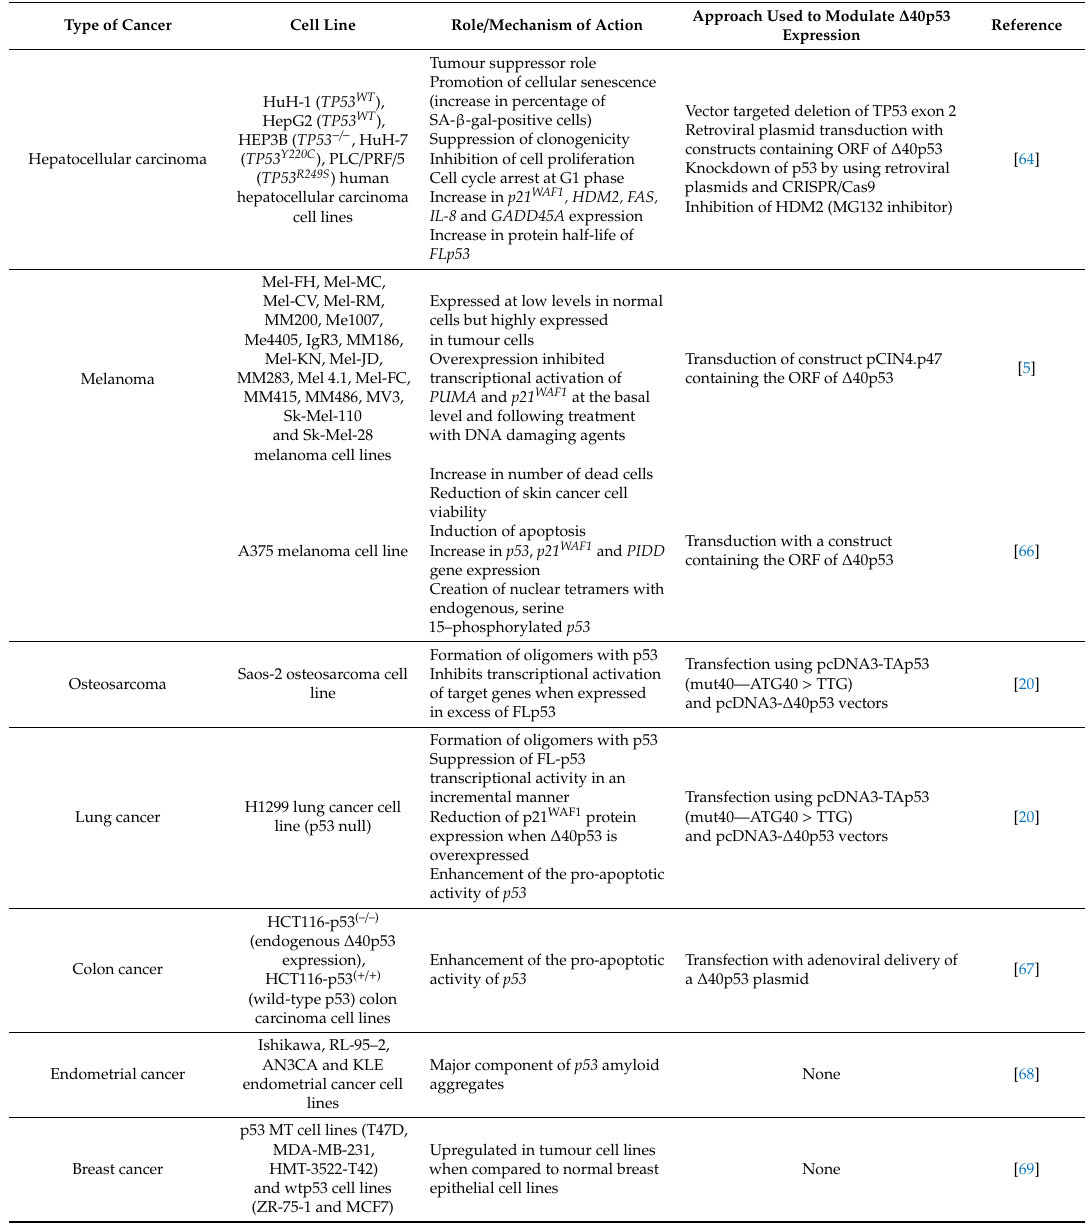
Table 1. Role of the ∆ 40p53 isoform in cancer in